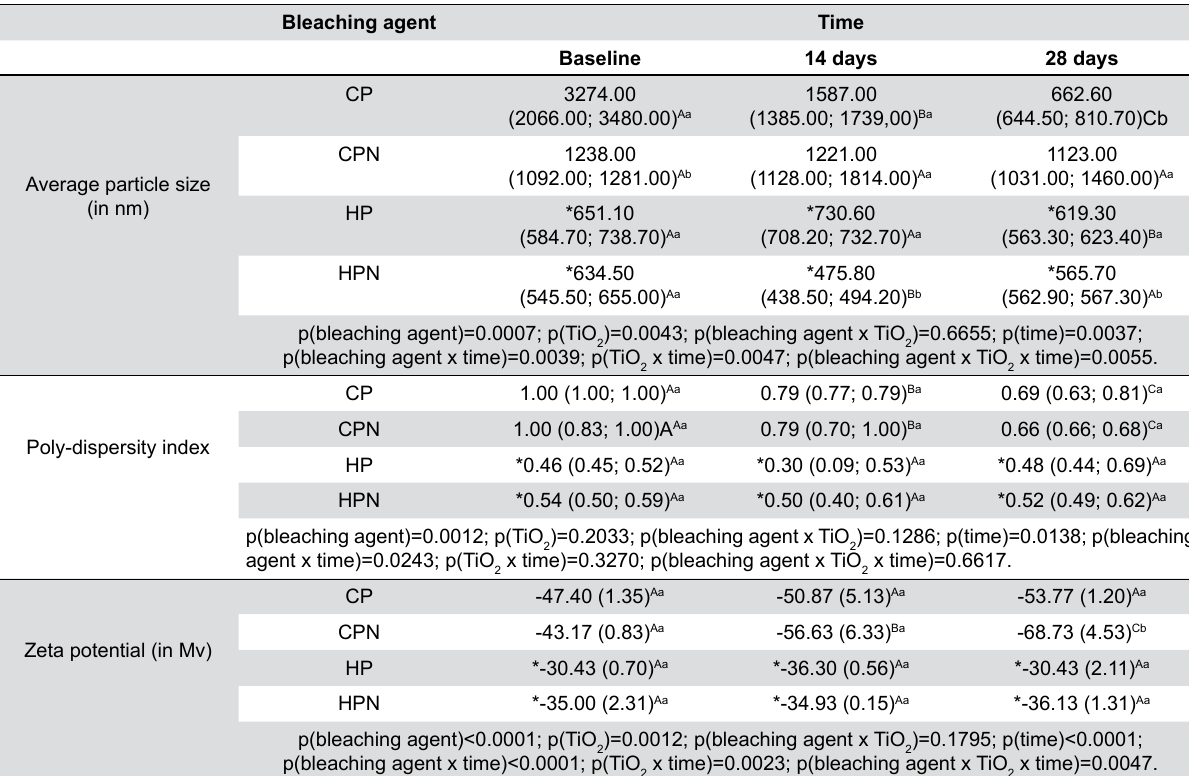
Titanium dioxide nanotubes incorporated into bleaching agents: physicochemical characterization and enamel color Table 2- Median (minimum value; maximum value) particle size and polydispersibility, and mean (standard deviation) zeta potential, as a function of the bleaching agent, addition of TiO and time-point 2